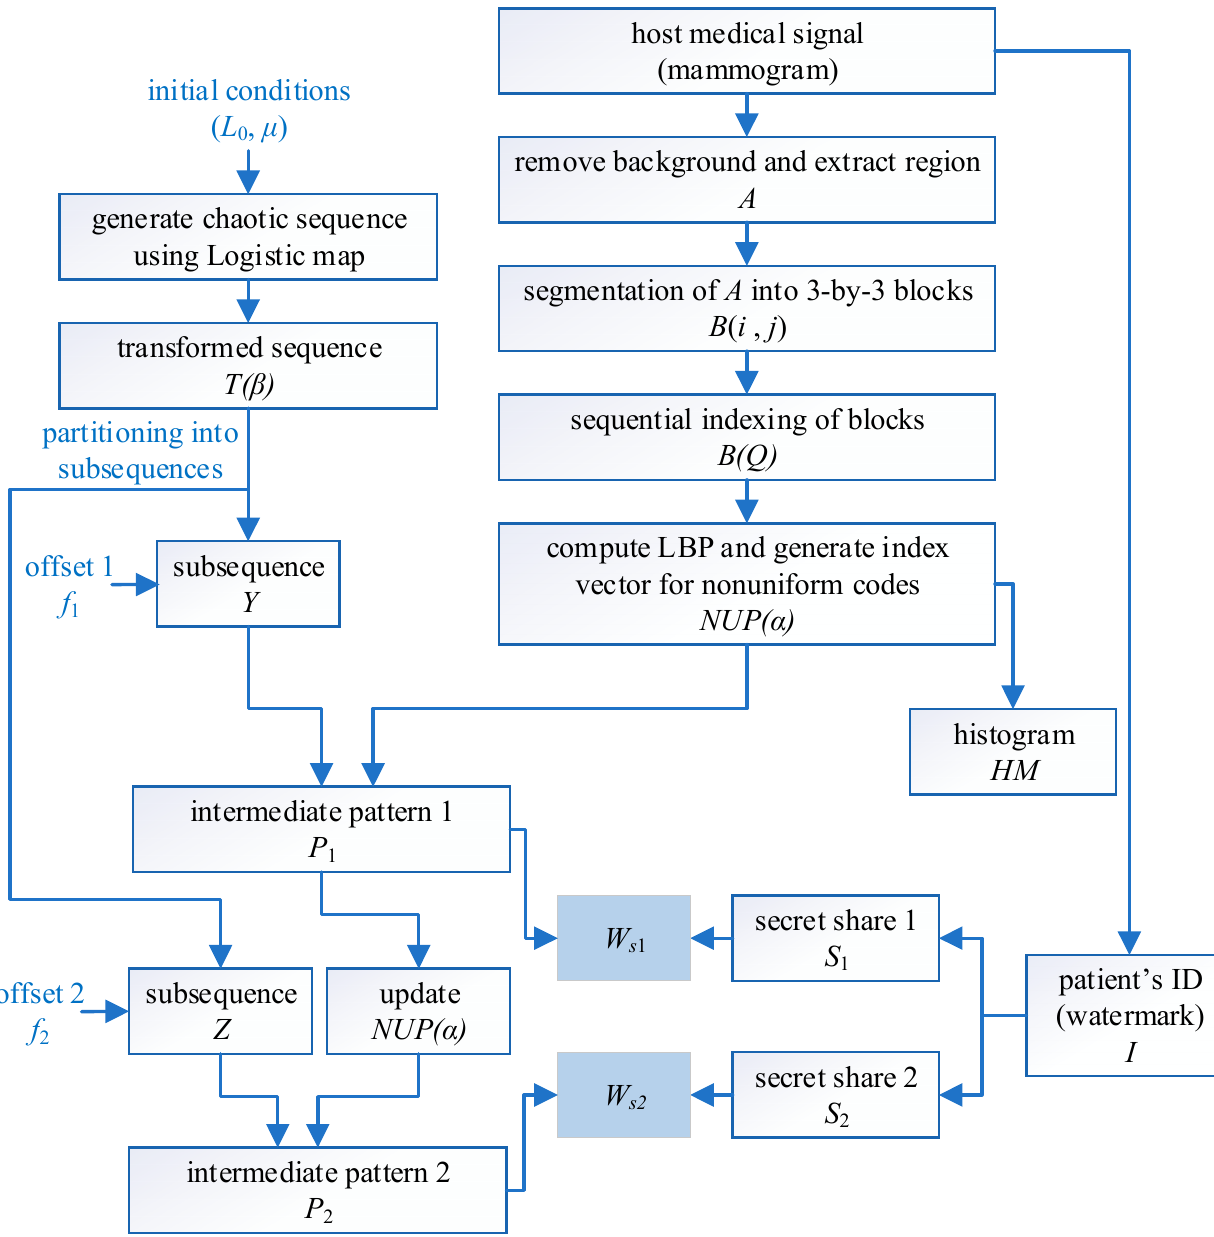
Figure 6. Block diagram of the embedding process of the proposed algorithm.